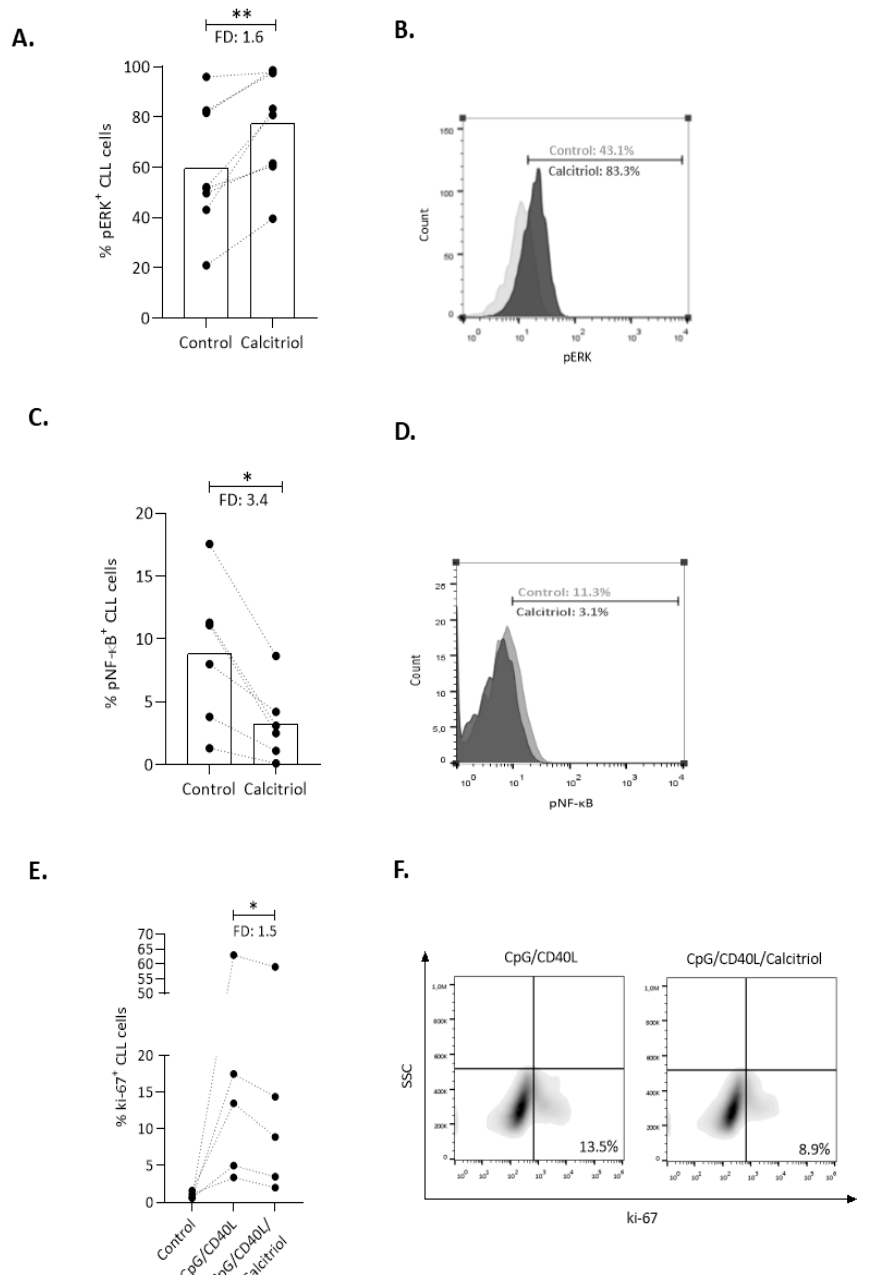
Figure 3. Calcitriol modulates key signaling molecules and inhibits CLL cell proliferation. ( A ) Cal- citriol treatment for 24 h led to increased percentage of pERK + CLL cells. ( B ) Representative histo- grams from flow cytometry analysis for pERK + cells in control and calcitriol-treated CLL cells for one CLL case. ( C ) Decreased percentage of pNF- κ B + CLL cells compared to unstimulated control cells after calcitriol supplementation; ( D ) representative case. ( E ) Flow cytometric analysis of proliferating cells (Ki-67 + ) in U-CLL cases treated with CpG/CD40L for four days supplemented with calcitriol at 48 h of culture. ( F ) Representative dot plot showing the decrease in Ki-67 + cells after calcitriol supplementation. Bars represent the median values and the Wilcoxon test was performed to assess statistical significance. * p < 0.05, ** p < 0.01, FD: Fold